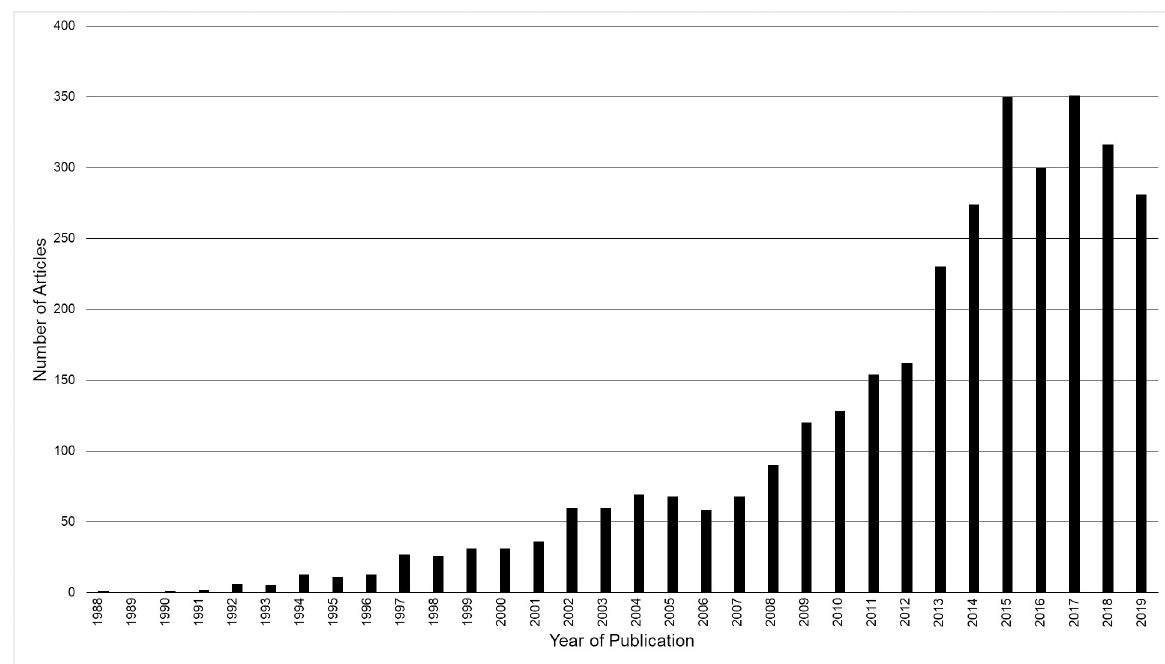
Fig 1. Telomere publications 1988–2019. All publications mentioning telomere length of human DNA from 1988 to 2019 obtained by searching “telomere,” “length,” and “human” in PubMed. Search was completed on May 25, 2020.